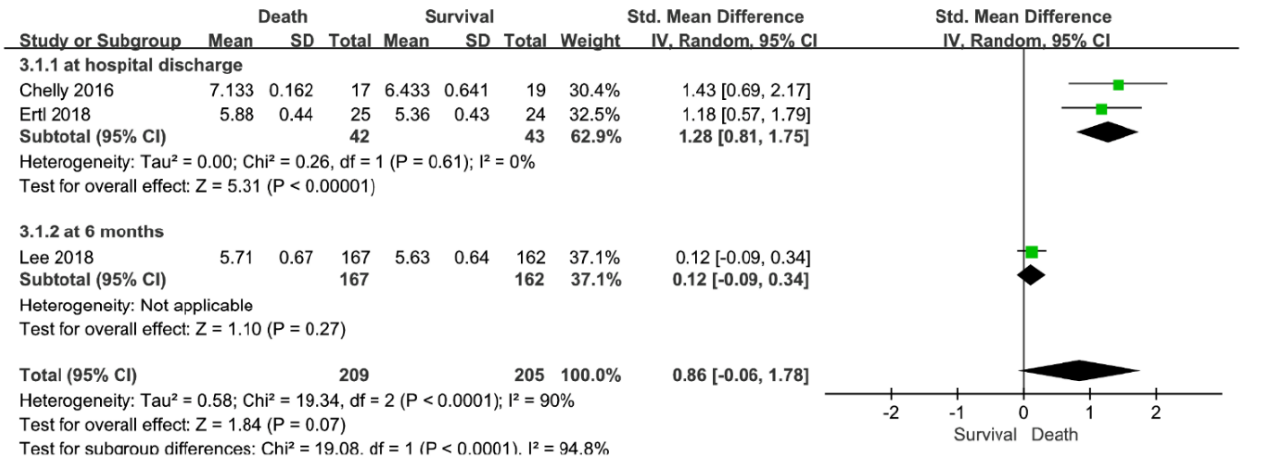
Figure 3. Forest plot for the association of ONSD with death [3,16,18]. Abbreviations: CI = confidence interval; ONSD = optic nerve sheath diameter; SD = standard